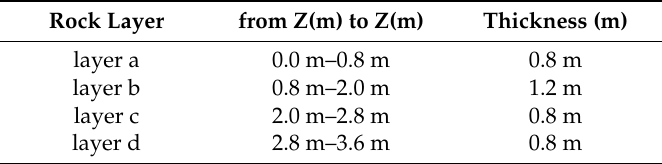
Figure 9. ( a ) Radargram F03 processed without any interpretation; ( b ) Radargram F03 processed with the interpretation of the detected layering (black dashed lines) and the detected sub-vertical fractures (different colors). Table 2. The thickness of the detected rock layers.